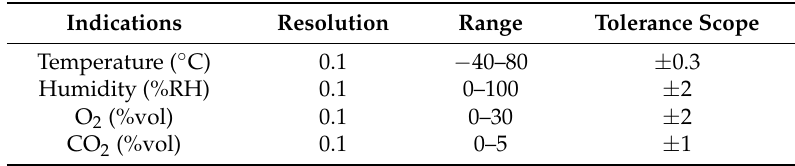
Table 3. Performance indicators of the device.